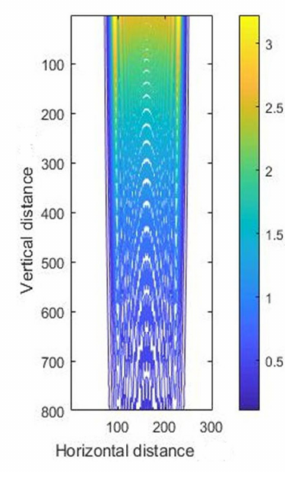
Figure 6. The contour map of intensity distribution for vertical